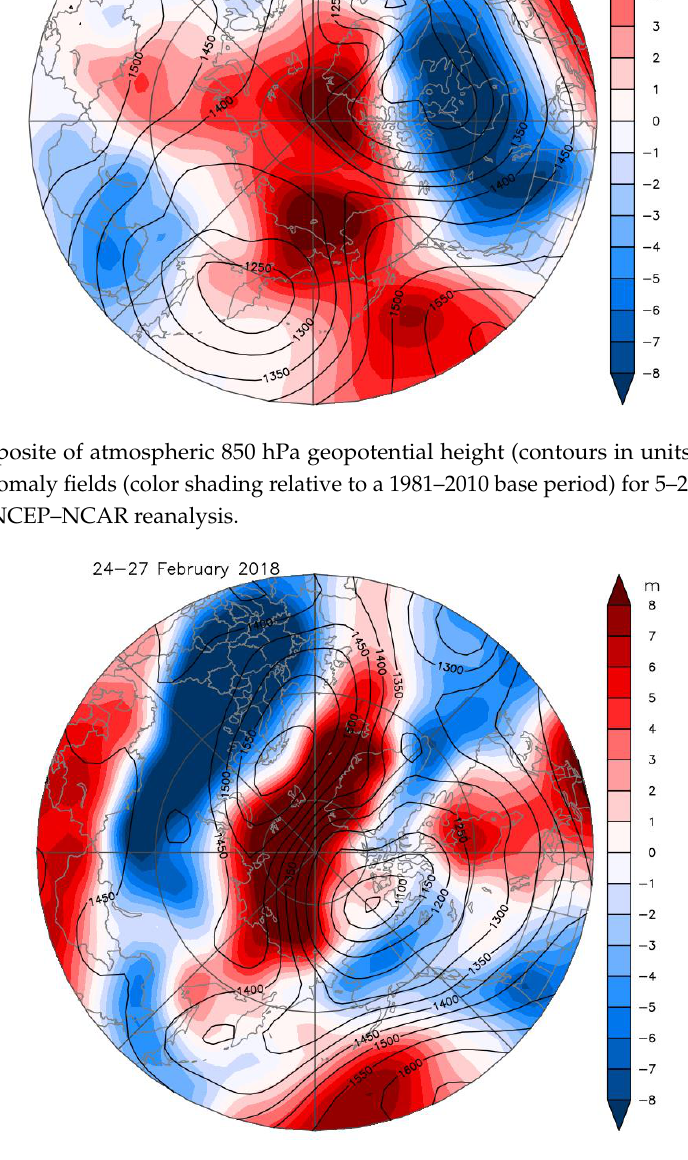
Figure 4. Composite of atmospheric 850 hPa geopotential height (contours in units of meters) and temperature anomaly fields (color shading relative to a 1981–2010 base period) for 5–23 February 2018. Data are from NCEP–NCAR reanalysis.